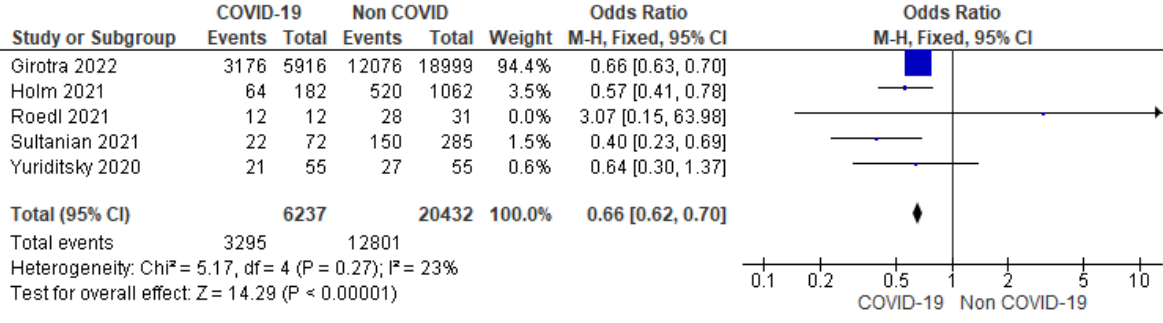
Figure 3. Forest plot showing group differences for ROSC among COVID-19 versus non-COVID-19 patients using fixed effect model. [12–15,17].